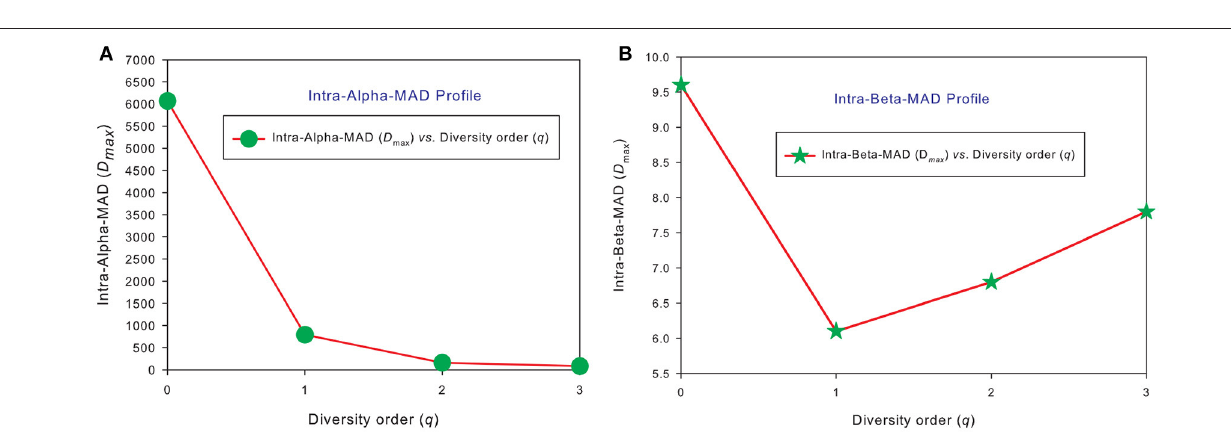
FIGURE 4 | The average MAD profiles of 150 individuals in the HMP cohort: (A) for alpha-MAD monotonically decreases with diversity order ( q ), and (B) for beta-MAD is valley-shaped. The average D max is calculated from the D max values of 150 MAD profiles for each diversity order q (the